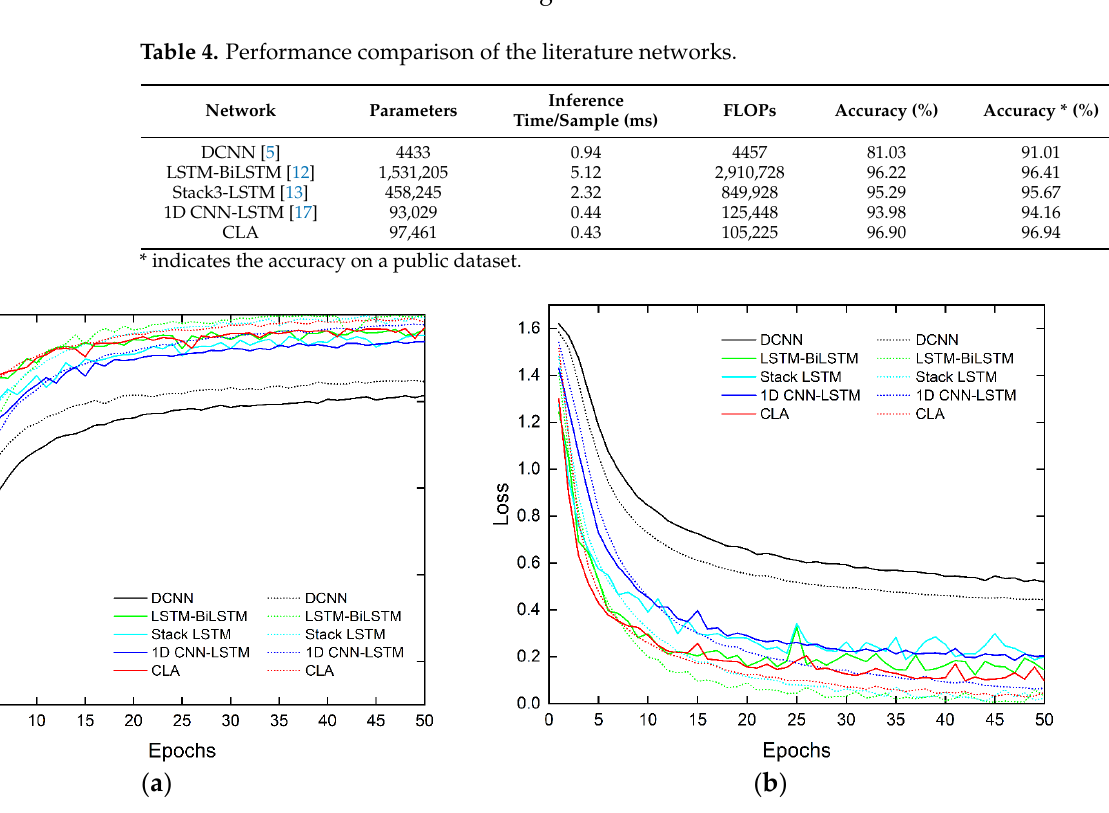
Table 4. Performance comparison of the literature networks.